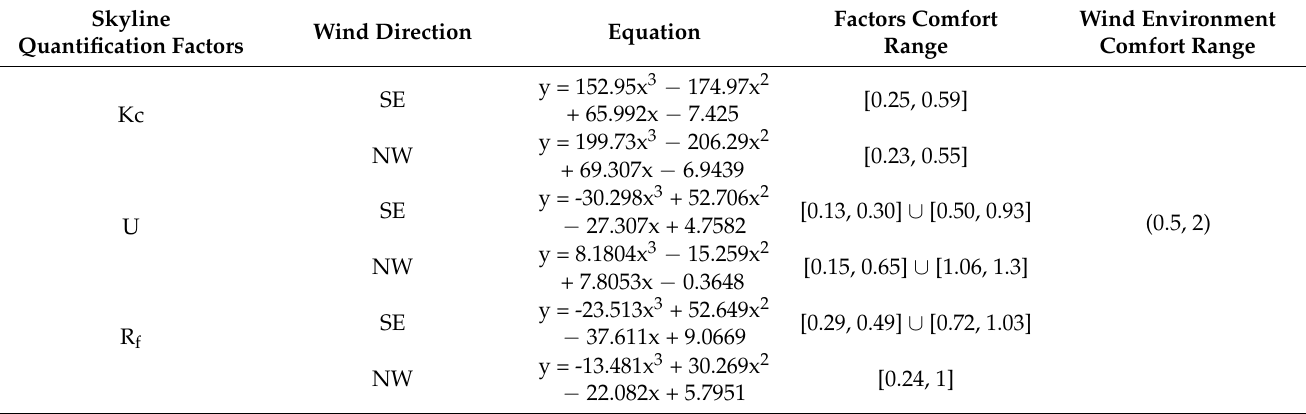
Table 19. The relationships between skyline quantification factors and average wind speed ratio.